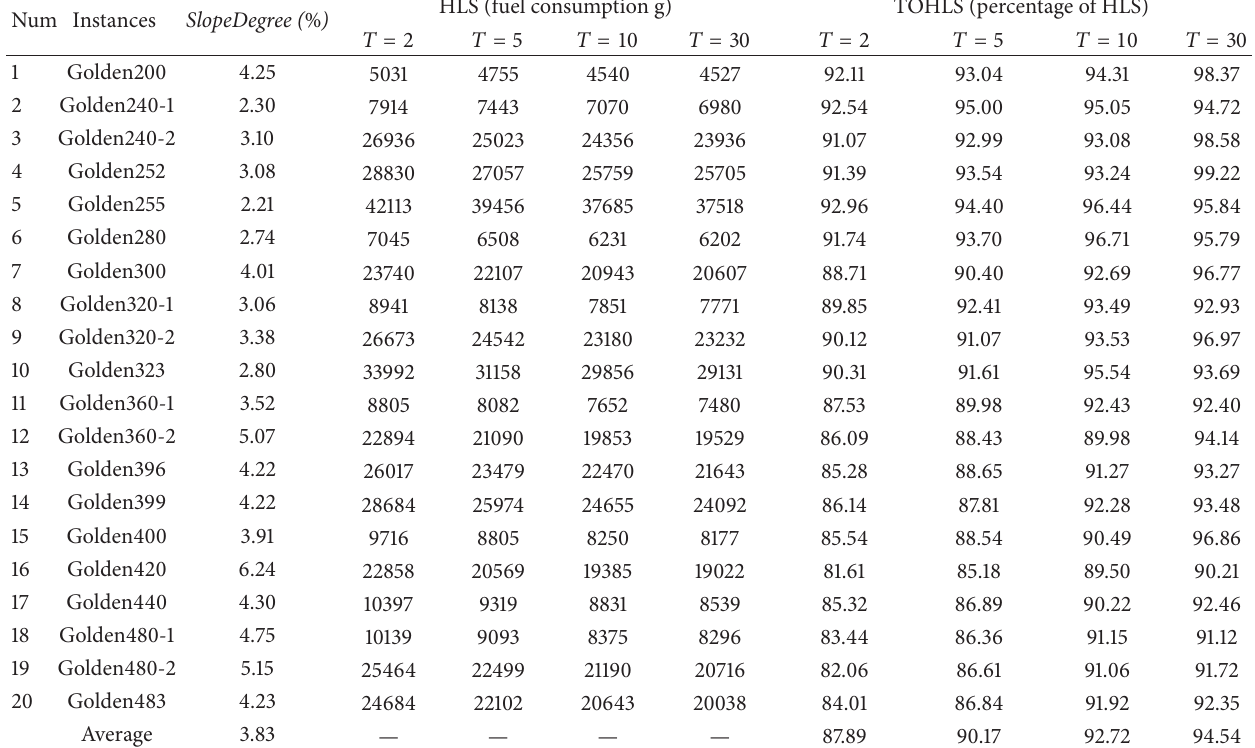
Table 8: Comparison between HLS and TOHLS when 𝑅 = 1000